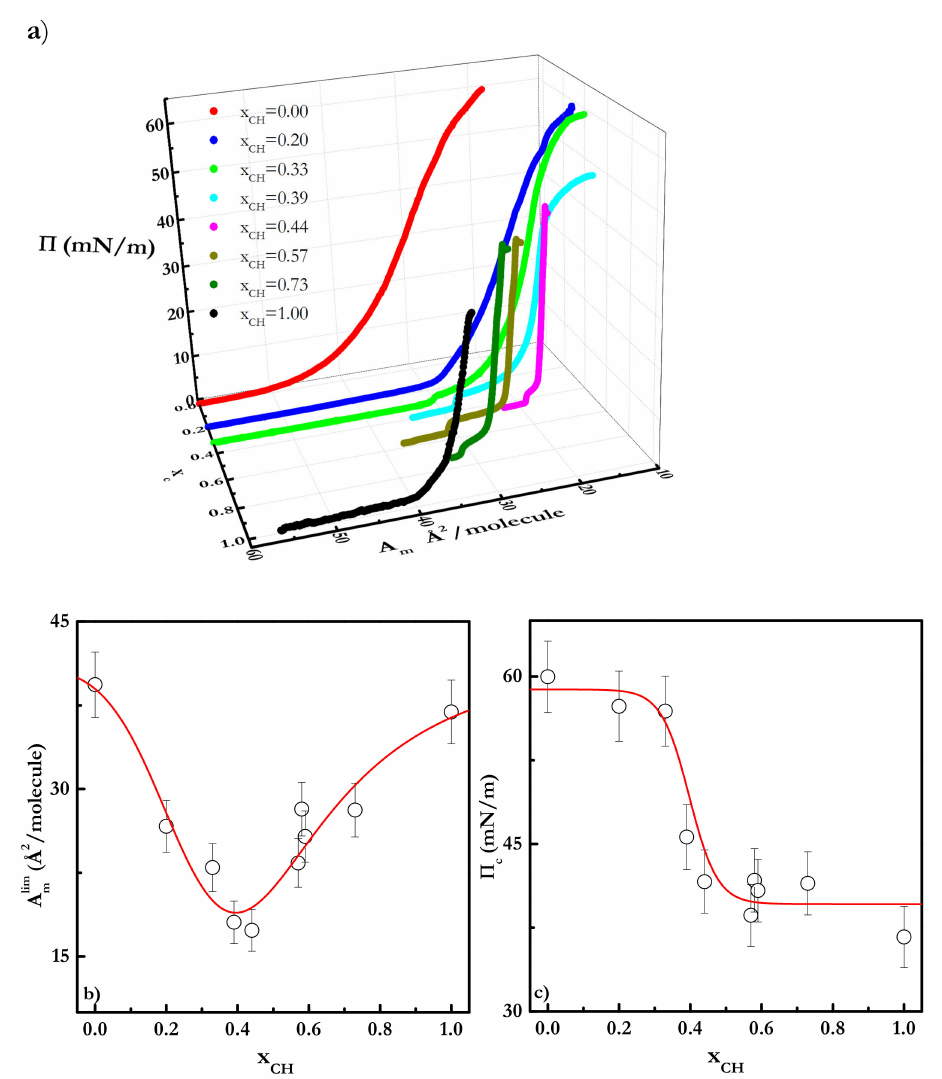
Figure 2. ( a ) Selected surface pressure–area per molecule isotherms for Langmuir monolayers of mixtures of CH and CE with different x CH spread at the water/vapor interface at 24 ◦ C. ( b ) Dependence on the limiting area per molecule on x CH for Langmuir monolayers of mixtures of CH and CE spread at the water/vapor interface at 24 ◦ C. ( c ) Dependence of the collapse pressure on x CH for Langmuir monolayers of mixtures of CH and CE spread at the water/vapor interface at 24 ◦ C. Note that solid lines in panel ( b , c ) are guides for the